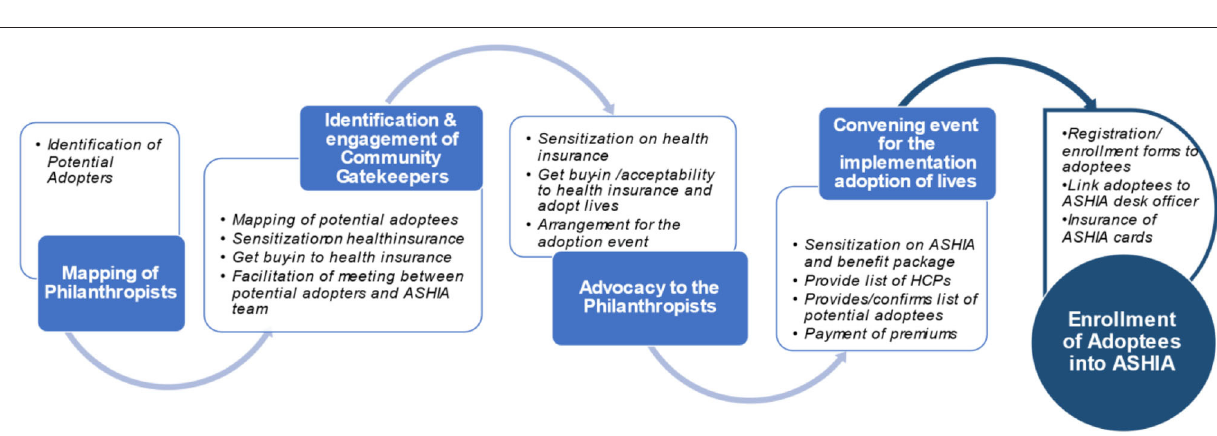
FIGURE 1 | The adoption model of social health insurance scheme in Anambra State, Nigeria.